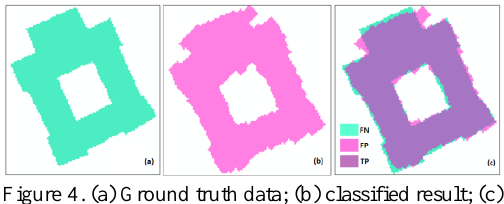
Figure 4. (a) Ground truth data; (b) classified result; (c)